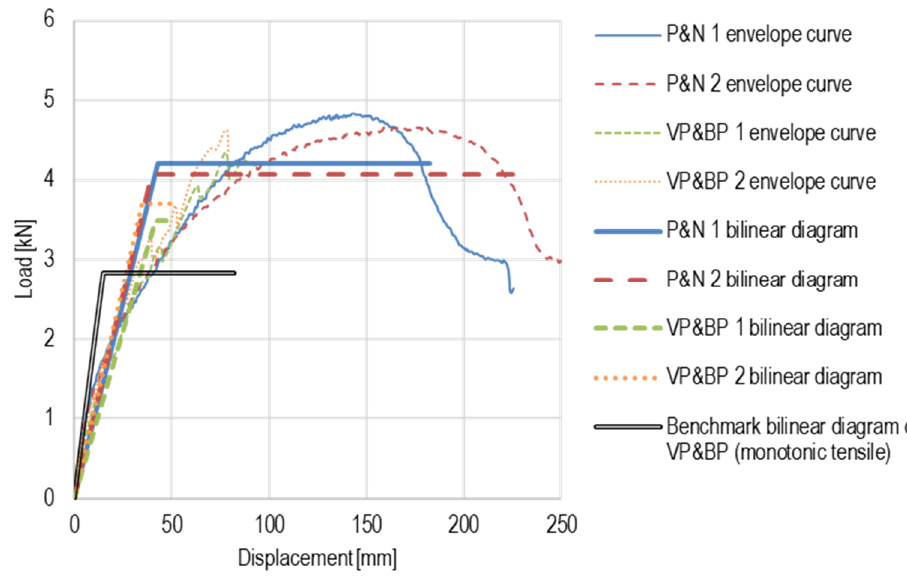
Figure 14. Envelope curves and bilinear diagrams of the full-scale in-plane cyclic tests. Table 5. The seismic performance parameters from the bilinear diagrams of the full-scale in-plane cyclic tests.